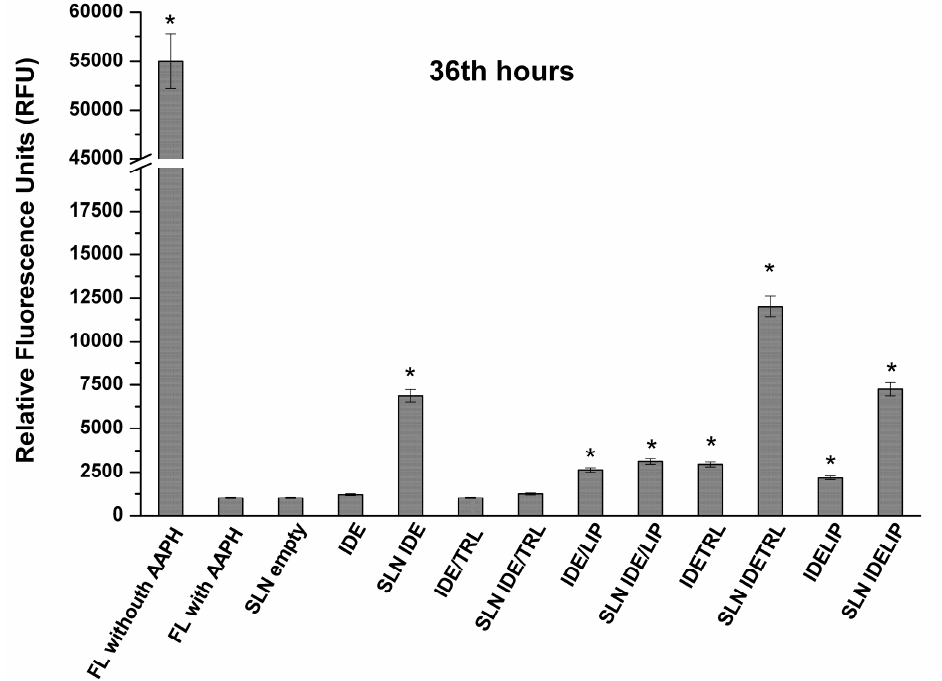
Figure 8. Antioxidant efficiency of IDE, IDETRL, IDELIP, and of the physical mixtures IDE/TRL and IDE/LIP, free or loaded into SLN, at the 36th hour. Data represent the mean of three independent experiments ± SD. * p < 0.05 with respect to the positive control.